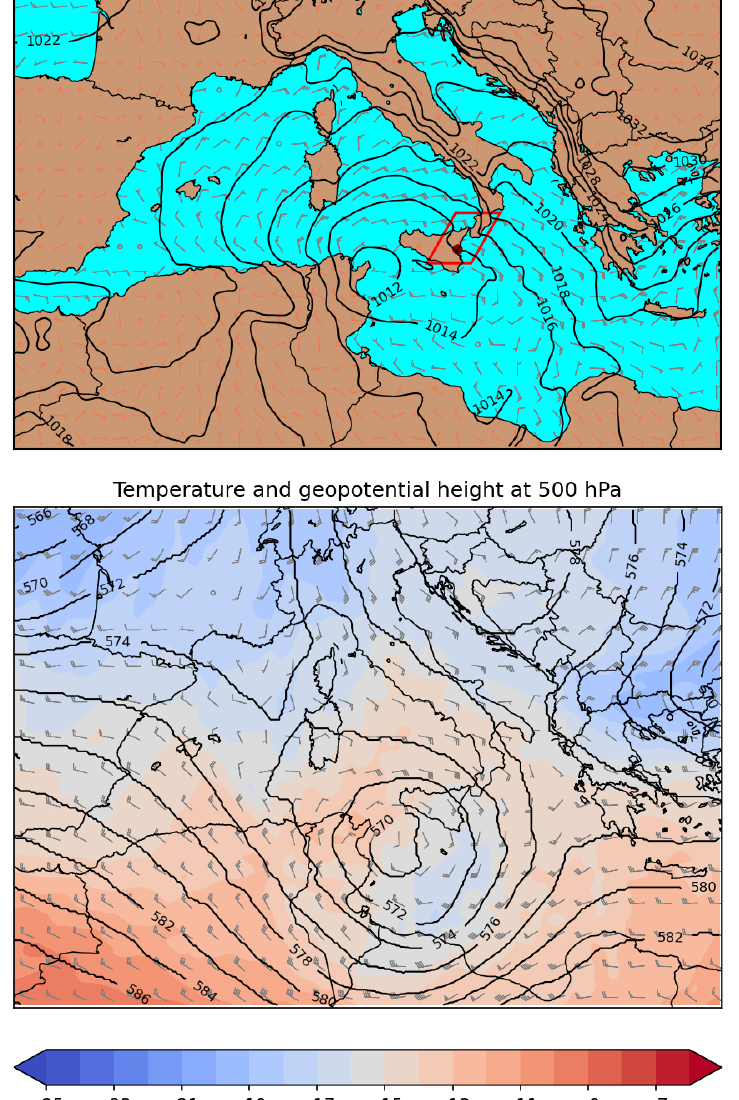
Figure 2. 25 October 2021 00UTC: SLP (hPa) and 10 m wind (knots) with the area of interest higlighted by a red rectangle and the Catania floodplain location highlighted with a dark red dot ( top ); Temperature ( ◦ C), Geopotential (dam) and wind (knots) at 500 hPa ( bottom ). Data from ECMWF